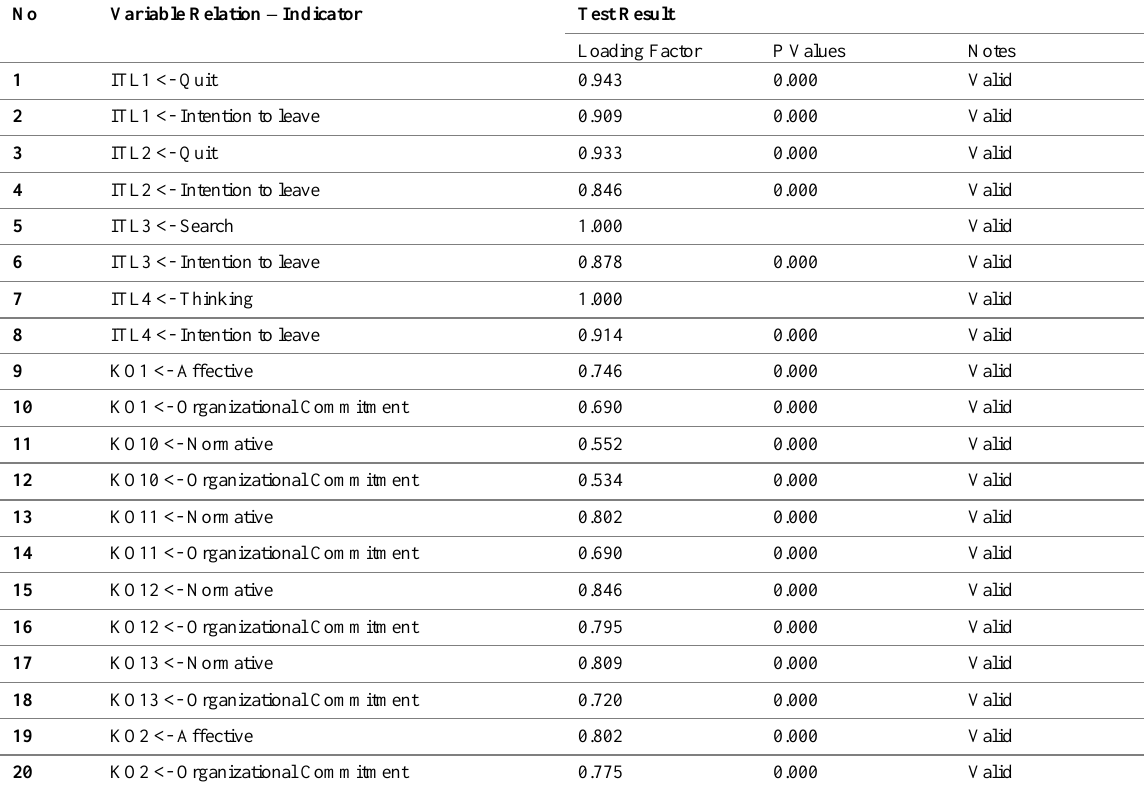
Figure 1: Result Analysis of Convergent Validity ; Source: processed primary data, 2021 Table 2: Indicator Test Outer